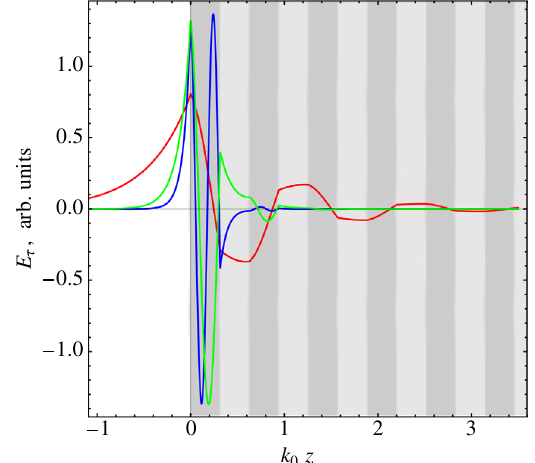
FIG. 9. The profiles of the tangential electric field for the first three surface states at the interface of air and a silicon-sapphire hypercrystal. The unit cell of the hypercrystal is formed by 1 - μ m- wide layers of silicon and sapphire, with the C axis of sapphire normal to the plane of the layers. The frequency is 500 cm − 1 . The dark-gray regions correspond to sapphire, and light-gray areas represent silicon.